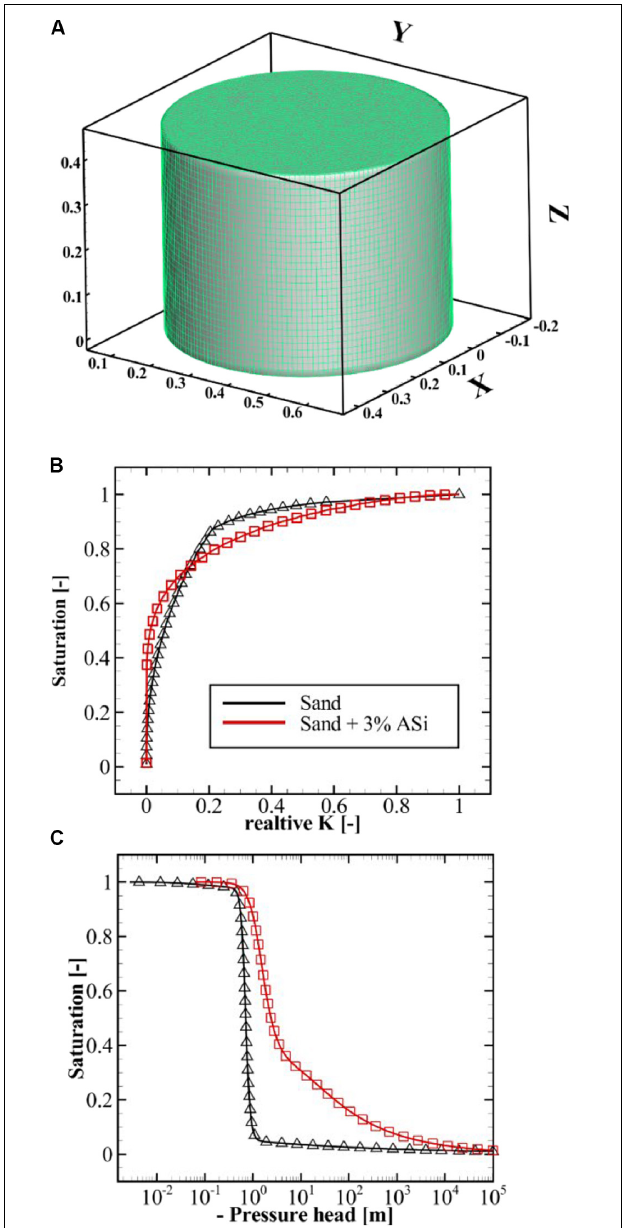
FIGURE 2 | (A) Computational grid of the HGS model representing the cylindrical lysimeter. (B) Soil retention functions (relative permeability’s vs saturation) used to simulate variably saturated flow in the HGS model (adopted from Schaller et al., 2020). (C) Soil retention functions (pressure head vs saturation) used to simulate variably saturated flow in the HGS model (adopted from Schaller et al., 2020).